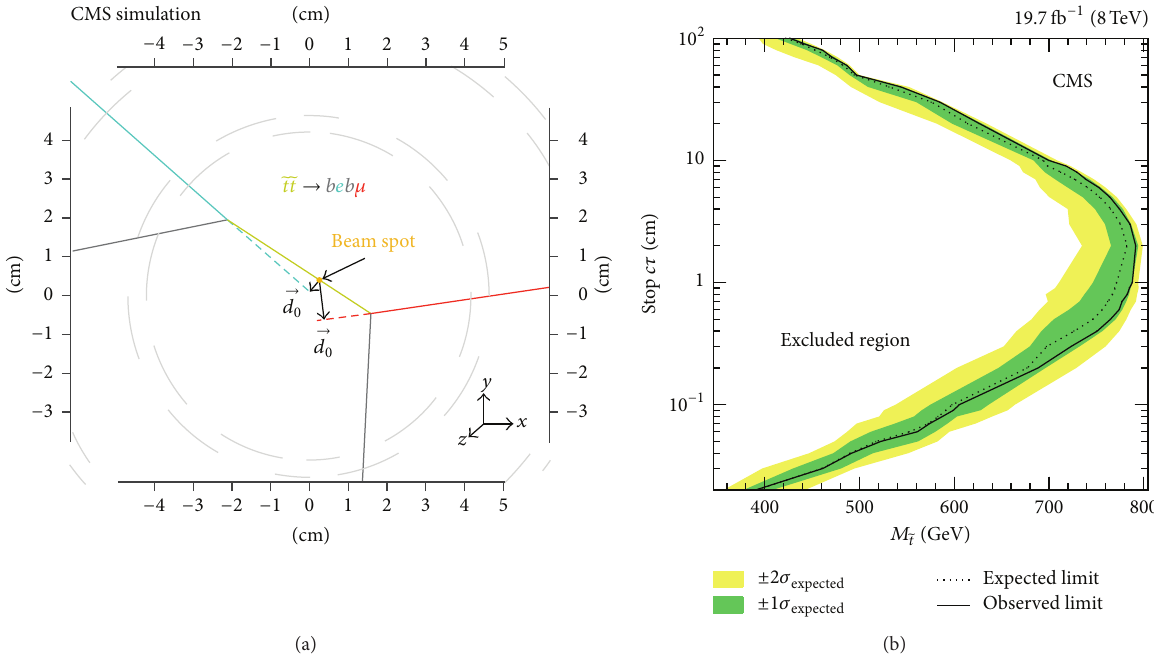
Figure 12: Limits on displaced RPV supersymmetry for stops decaying with equal rates into the three leptonic flavors [20]. On panel (a), a sample schematic event display is shown. The panel (b) gives the exclusion in the stop lifetime-mass plane. Points to the left of the solid black curve are excluded. Color codes as in Figure